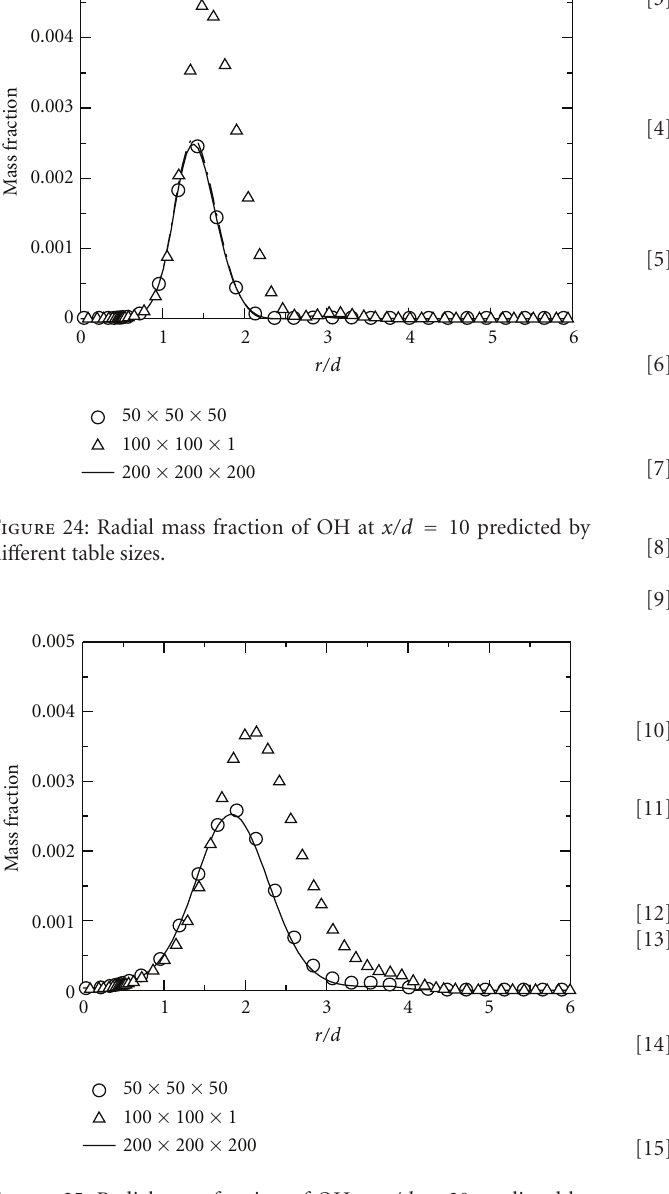
Figure 25: Radial mass fraction of OH at x/d = 20 predicted by di ff erent table